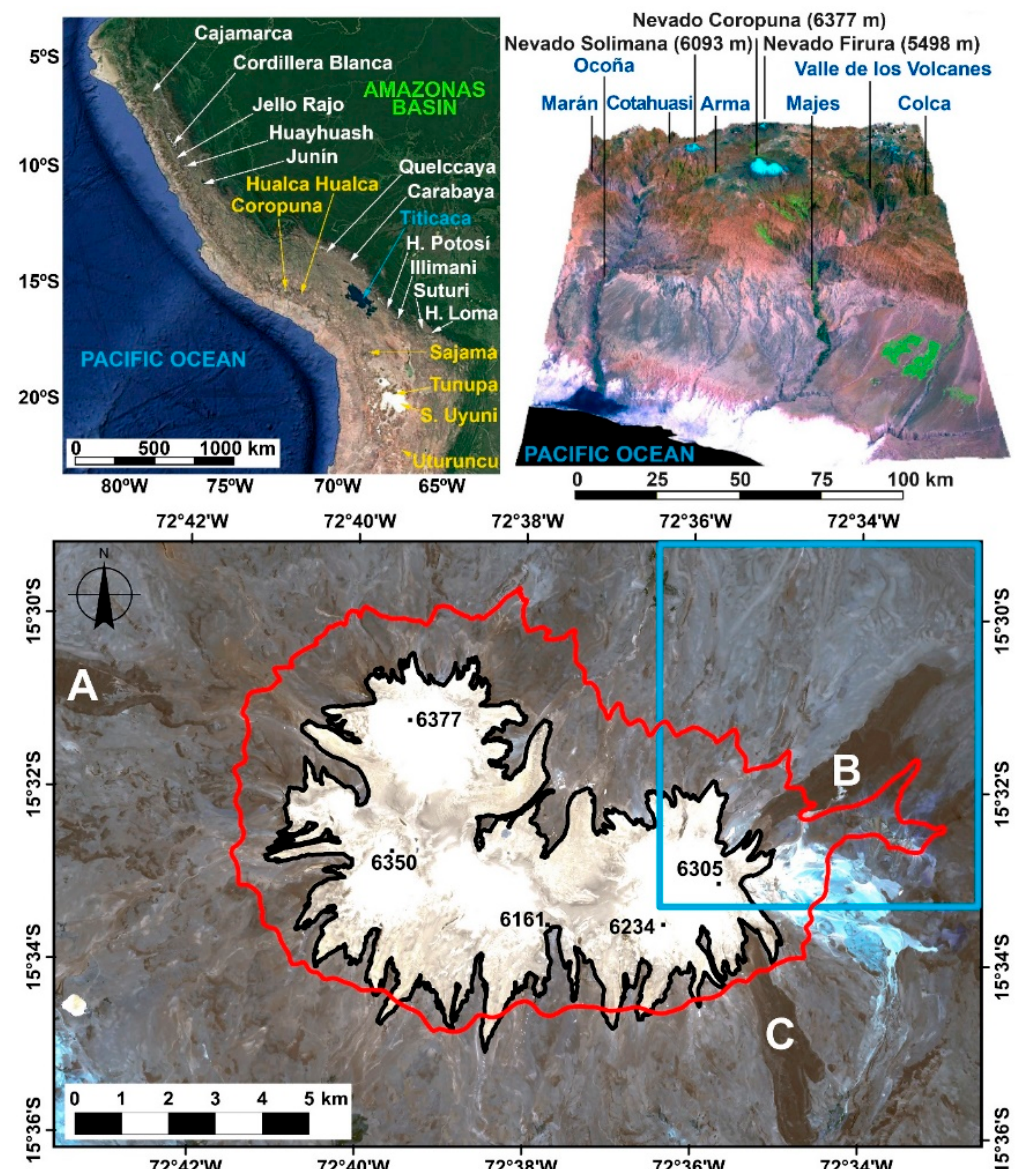
Figure 1. Top left: mountains in the Humid (white text) and Arid Tropical Andes (yellow) mentioned in this work. Top right: the highest mountains (black) and the main rivers (blue) in Coropuna surroundings (3-D model). Bottom: RapidEye satellite image (6 November 2010) showing the Coropuna summit area, the glacier system limits at 2010 (black line), the 0 °C air temperature isotherm (2007–2008; red line [51]) and the youngest lava flows (A, B, C). Blue frame: mapped area in Figure 4.